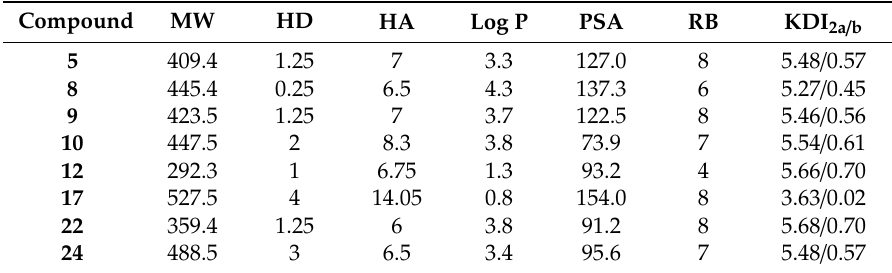
Table 2. Molecular descriptors of the hit